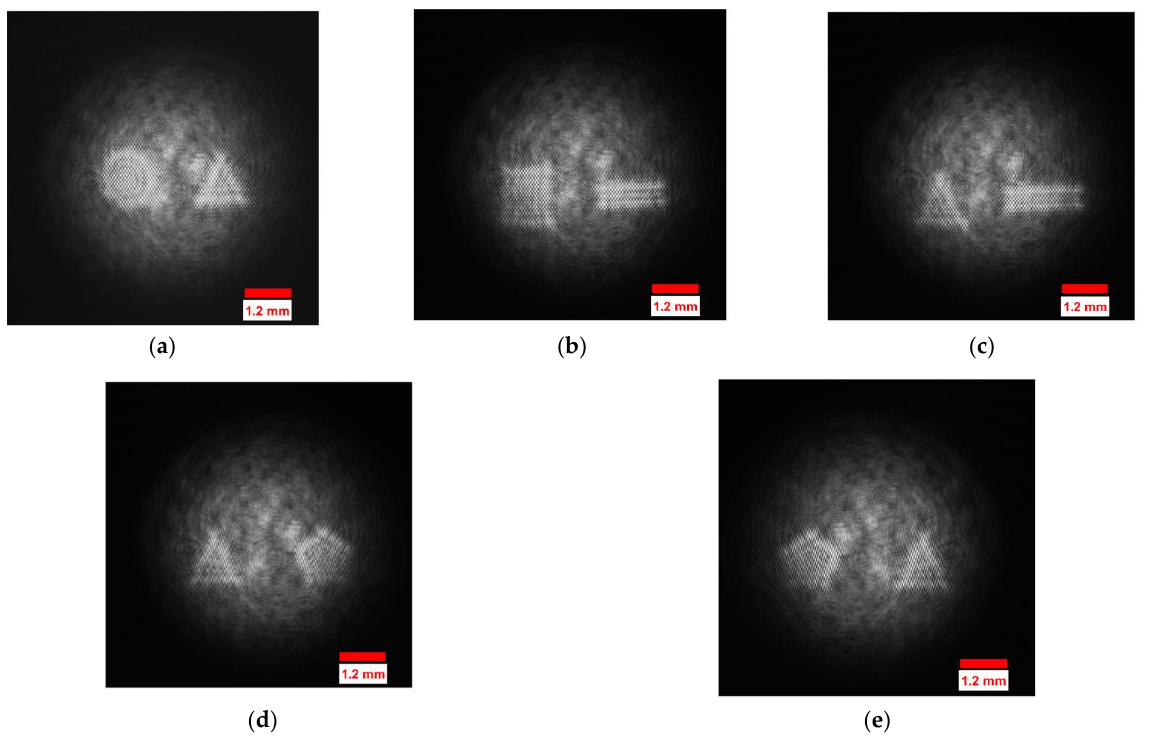
Figure 4. Representative images of the digital holograms of 3D objects recorded at distance of d 3 = 200 mm: ( a ) circle – triangle ( 𝑏 𝑑 d 3 = 200 mm: ( a ) circle–triangle ( b d pentagon ( 𝑜 𝑑 ); ( e ) pentagon – triangle ( 𝑟 𝑑 3 pentagon ( o d ); ( e ) pentagon–triangle ( r d 3